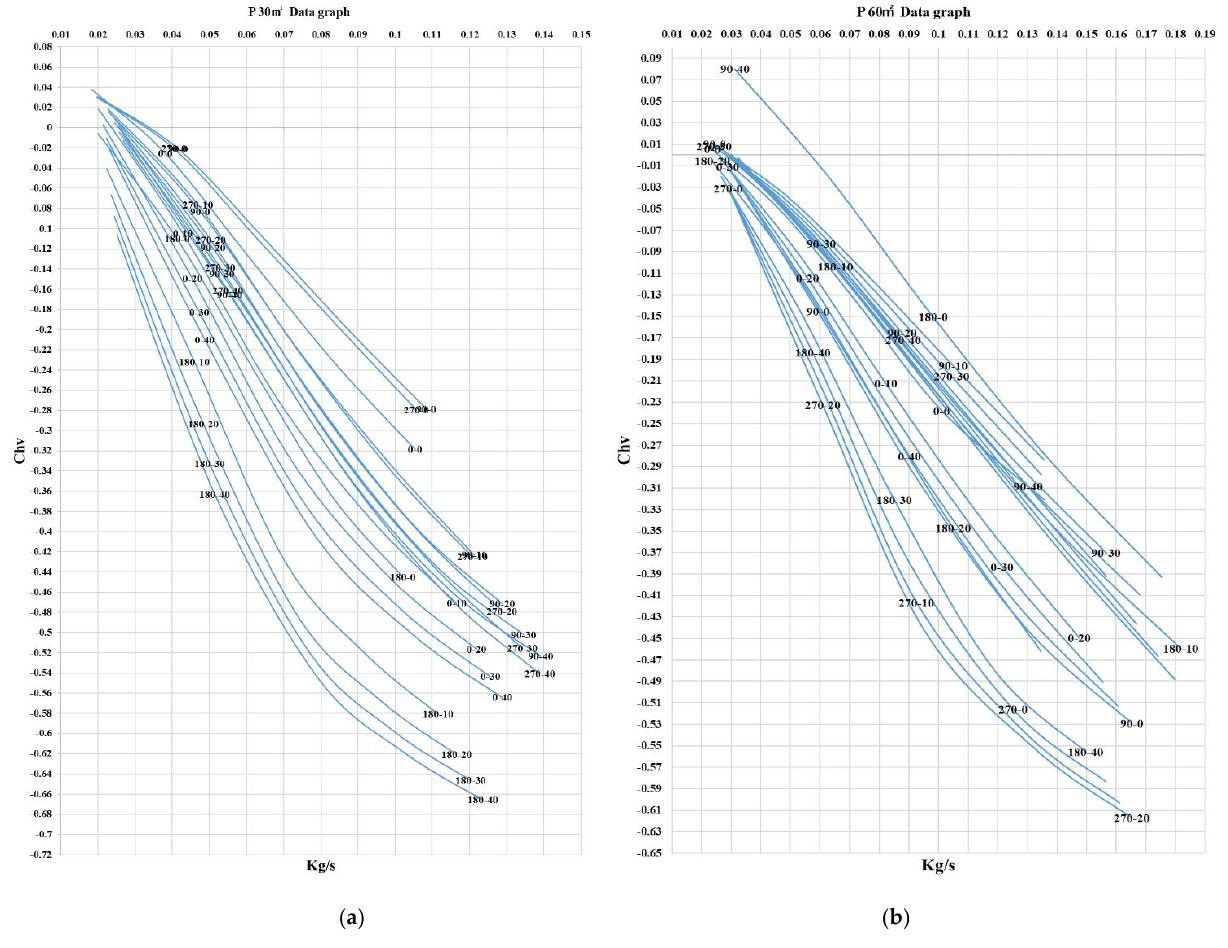
Figure 5. Example nomograph of ventilation heat gain correction factor according to azimuth, height, and maximum ventilation air volume (Kg/s) (central region) ( a ) plate type 30 m 2 ( b ) plate type 60 m 2